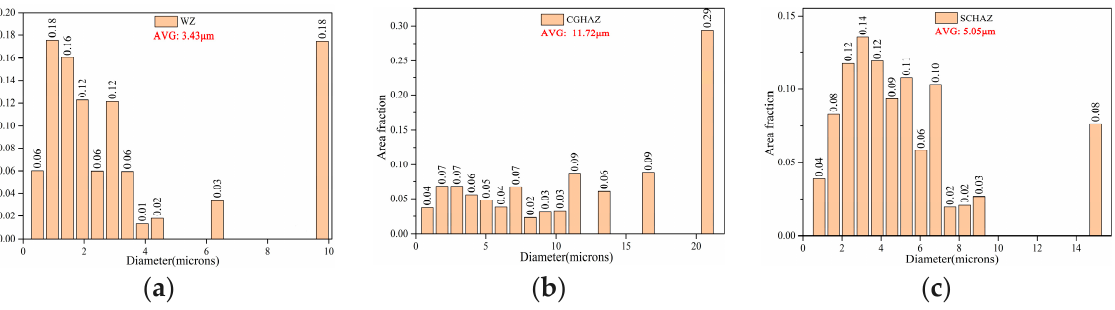
Figure 14. The distributions of grain sizes in different locations of the welded joint: ( a ) WM; ( b ) CGHAZ; ( c ) SCHAZ.